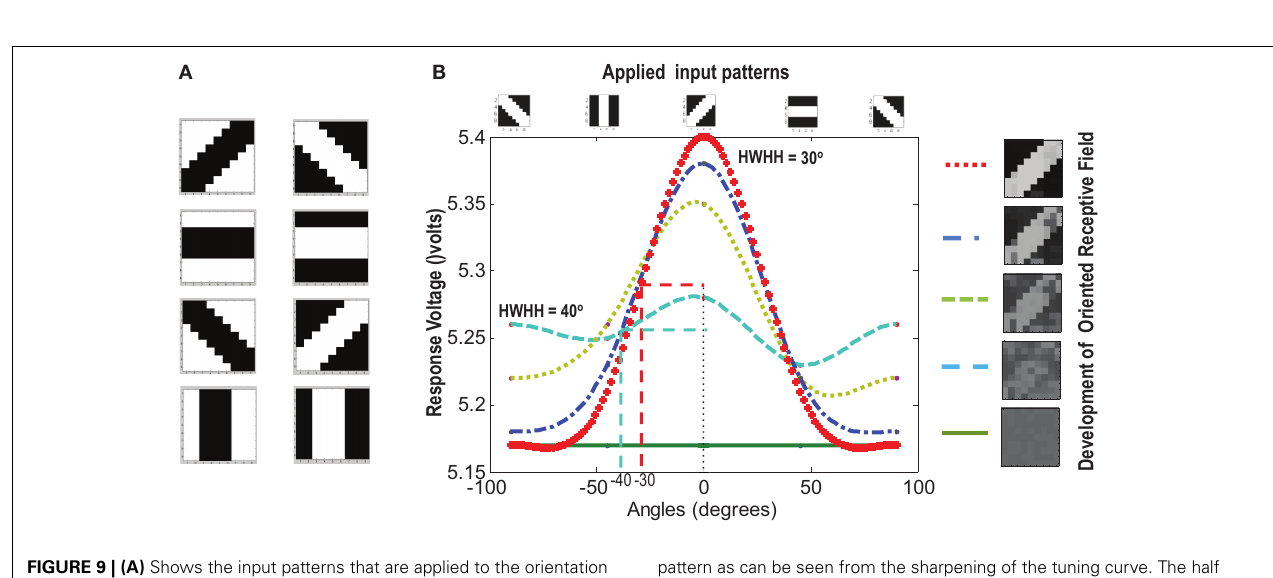
FIGURE 8 | Simplified and distributed layout of a 3 × 3 portion of the 9 × 9 receptive field of our orientation selective cell. (A) Shows the symbolic representation of a ts-WTA cell. In subsequent figures, the gray square represents a ts-WTA. (B) Is the feed-forward MOSFET network that takes the output of the individual ts-WTAs and feeds them to the OR Cell output. This is a read out node from where self-activation of the cell can be